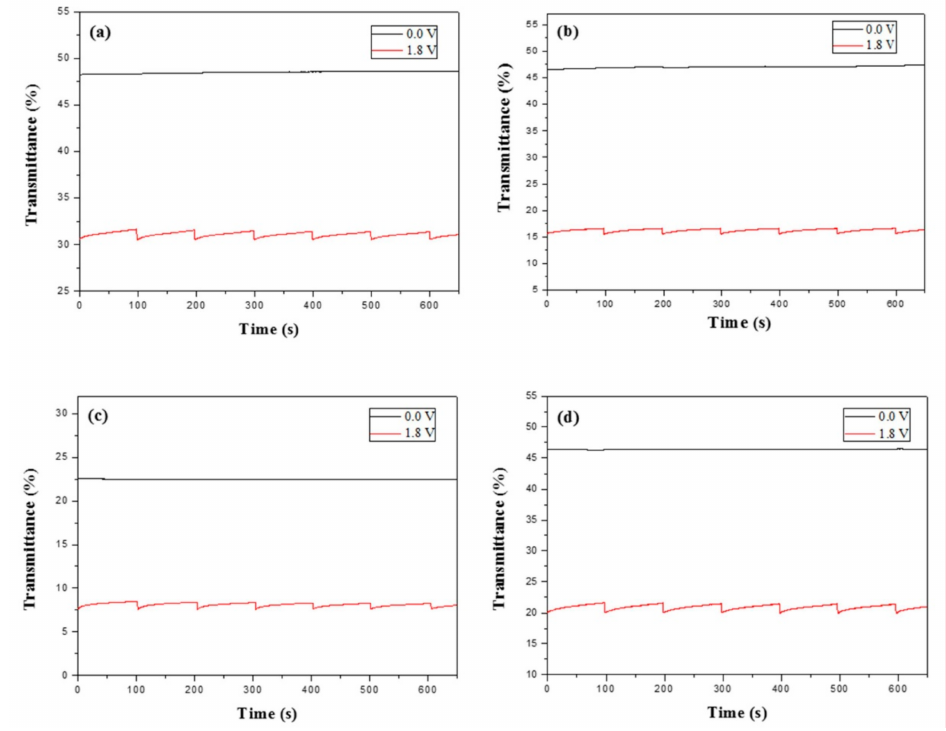
Figure 12. Open circuit stability of ( a ) PBPBC/PEDOT, ( b ) P(BPBC- co -BT)/PEDOT, ( c ) P(BPBC- co - CDT)/PEDOT, and ( d ) P(BPBC- co -CDTK)/PEDOT